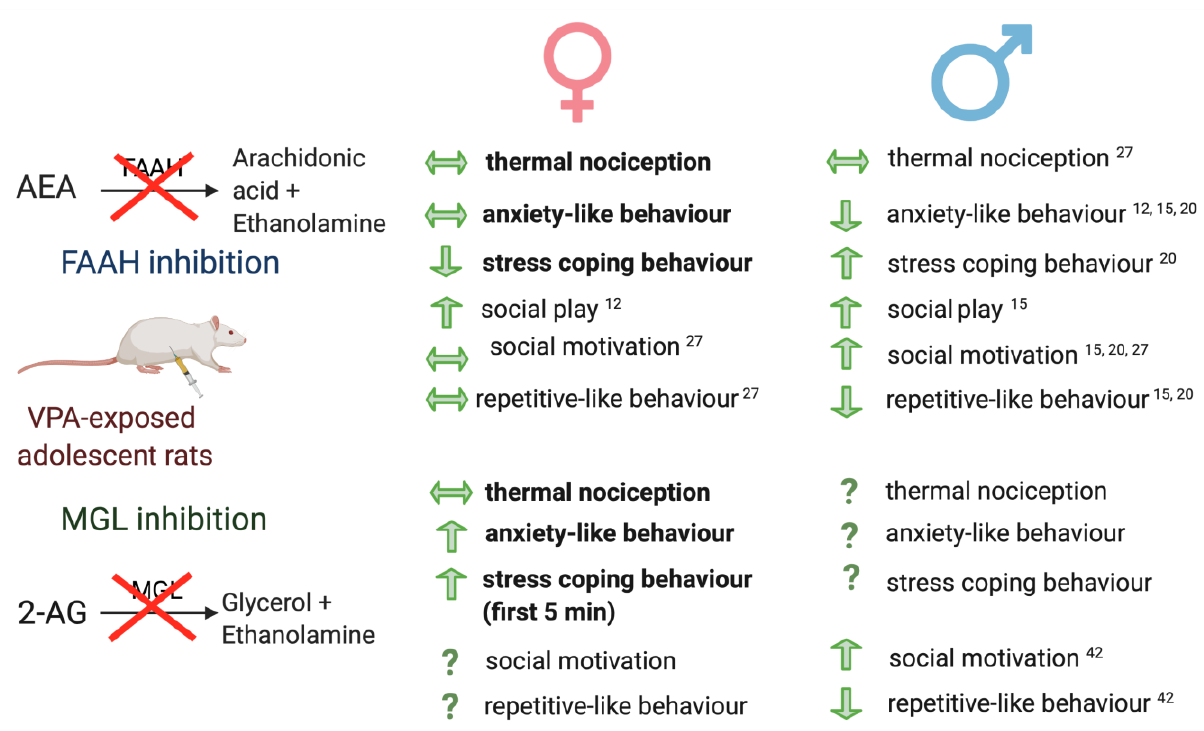
Figure 4. Schematic depicting the effects of FAAH and MGL inhibition on anxiety-like behaviour in VPA-exposed female and male rats. Bold highlights the data depicted in the current study. References provided for data cited in published